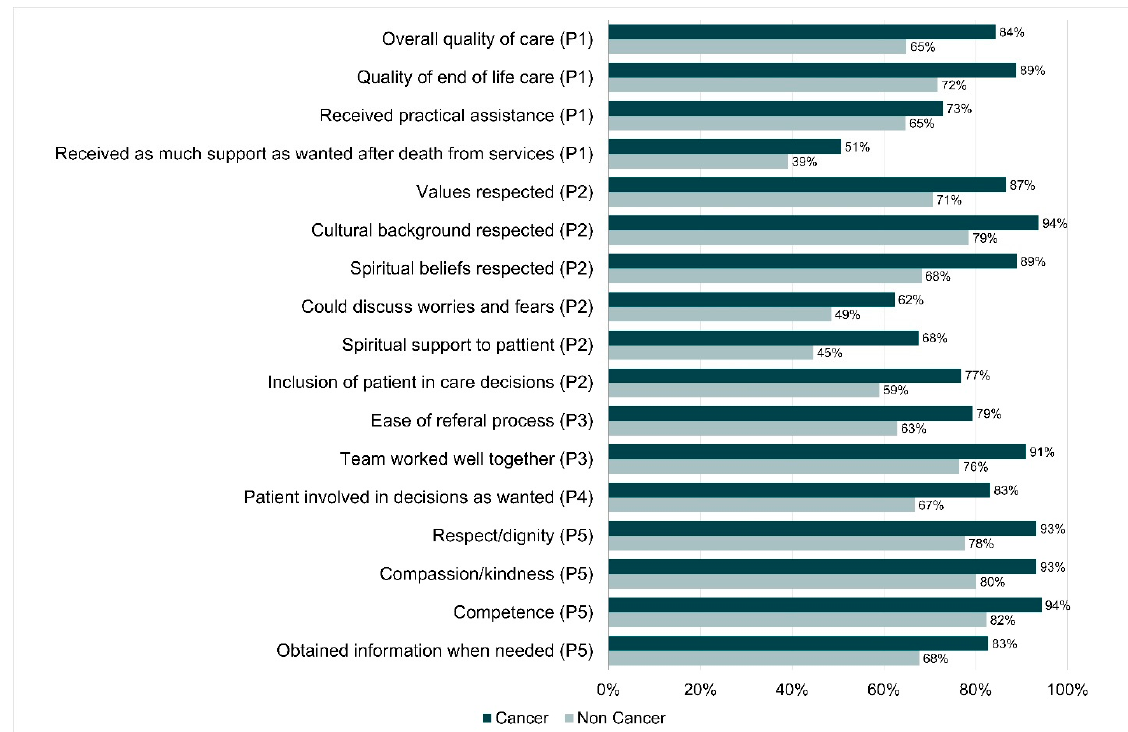
Figure 2. Differences in care between cancer and non-cancer conditions (with EOL strategy priority number).